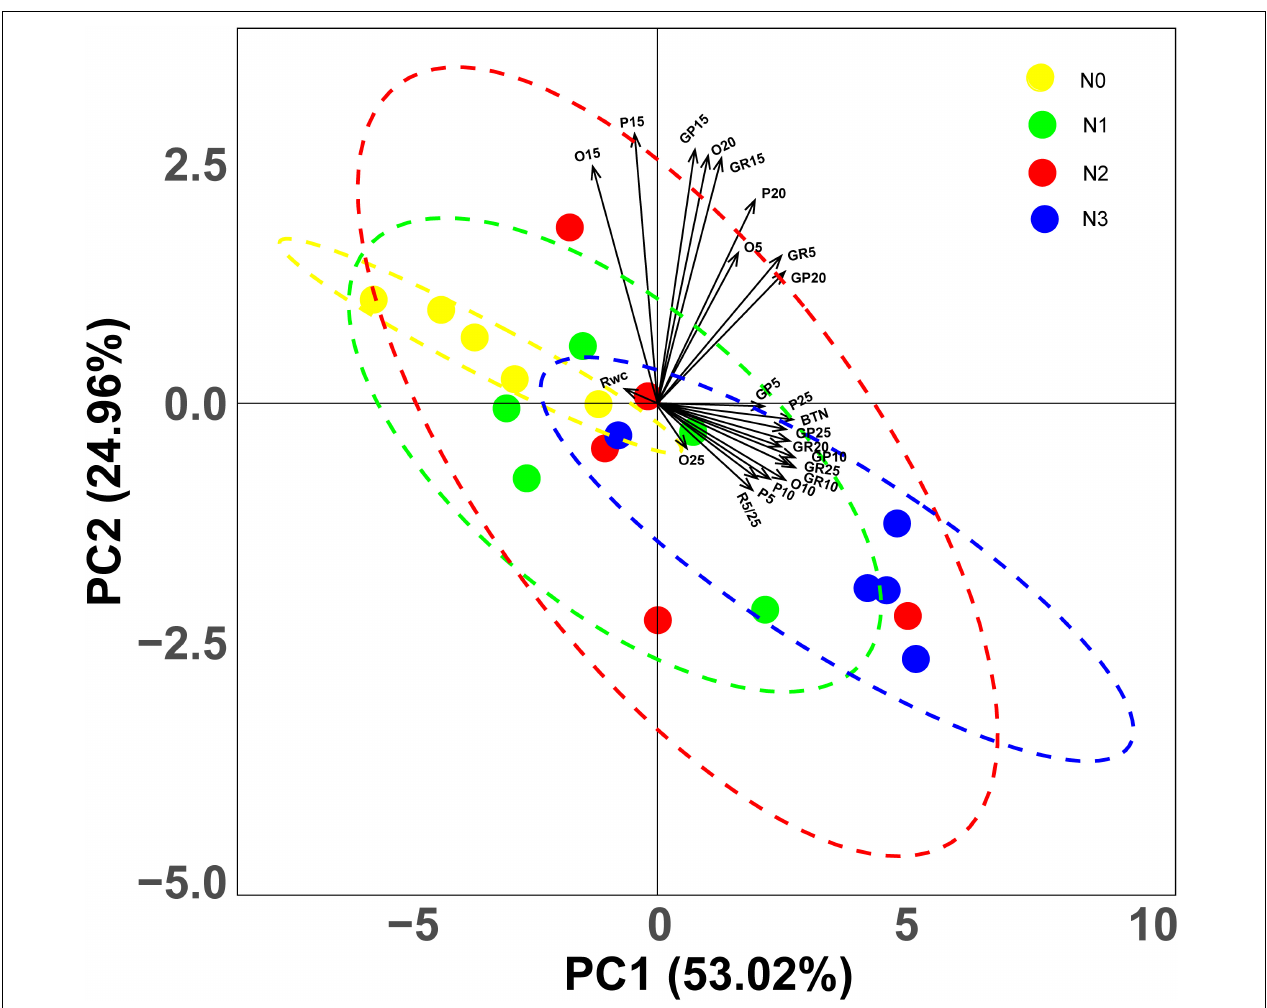
FIGURE 4 | Principal Component Analysis (PCA) representing the two main axes of variation in germination traits, based on community weighted mean (CWM) of 23 variates. GP5, GP10, GP15, GP20 and GP25: germination percentage at 5, 10, 15, 20 and 25 ◦ C respectively; GR5, GR10, GR20 and GR25: germination rate at 5, 10, 15, 20 and 25 ◦ C, respectively; BTN: breadth of temperature niche for germination; O5, O10, O15, O20 and O25: occupation of temperature niche for germination at 5, 10, 15, 20 and 25 ◦ C, respectively; P5, P10, P15, P20 and P25: proportion of temperature niche for seed germination 5, 10, 15, 20 and 25 ◦ C, respectively. Dots represent quadrats, different colors represent different levels of nitrogen